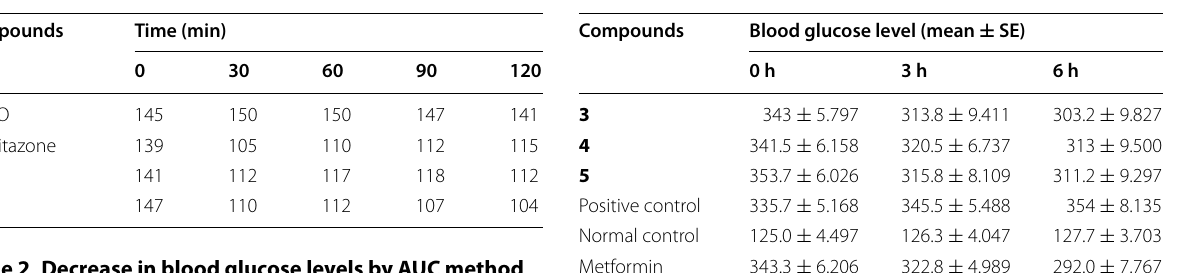
Table 3 Blood glucose level (mg/dl) of synthesized